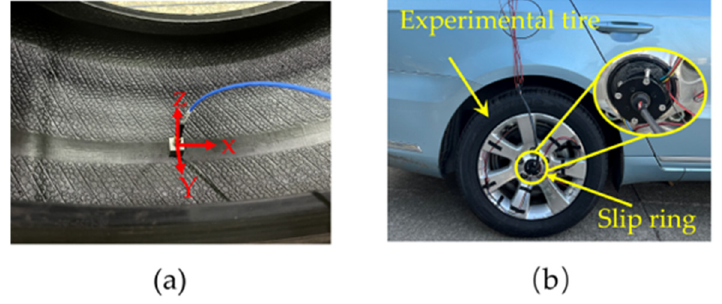
Figure 7. Installation diagram of the sensor, ( a ) sensor location ( b ) experimental tire equipment.